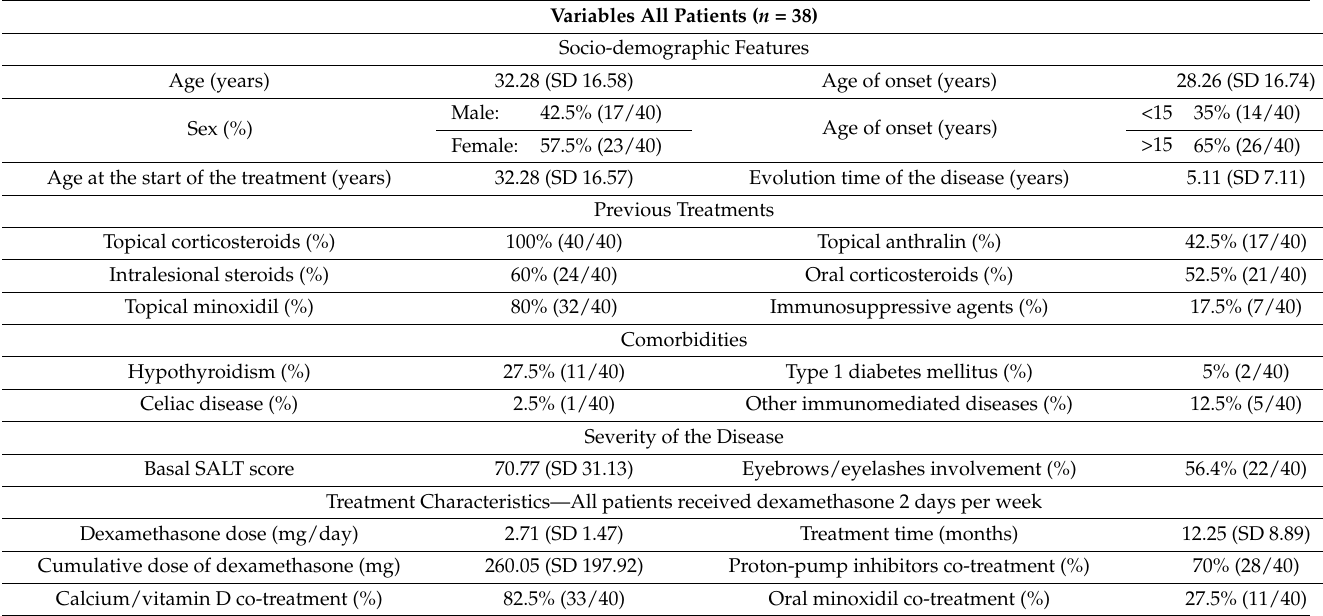
Table 1. Socio-demographic and clinical features of the sample and characteristics of dexametha- sone treatment.